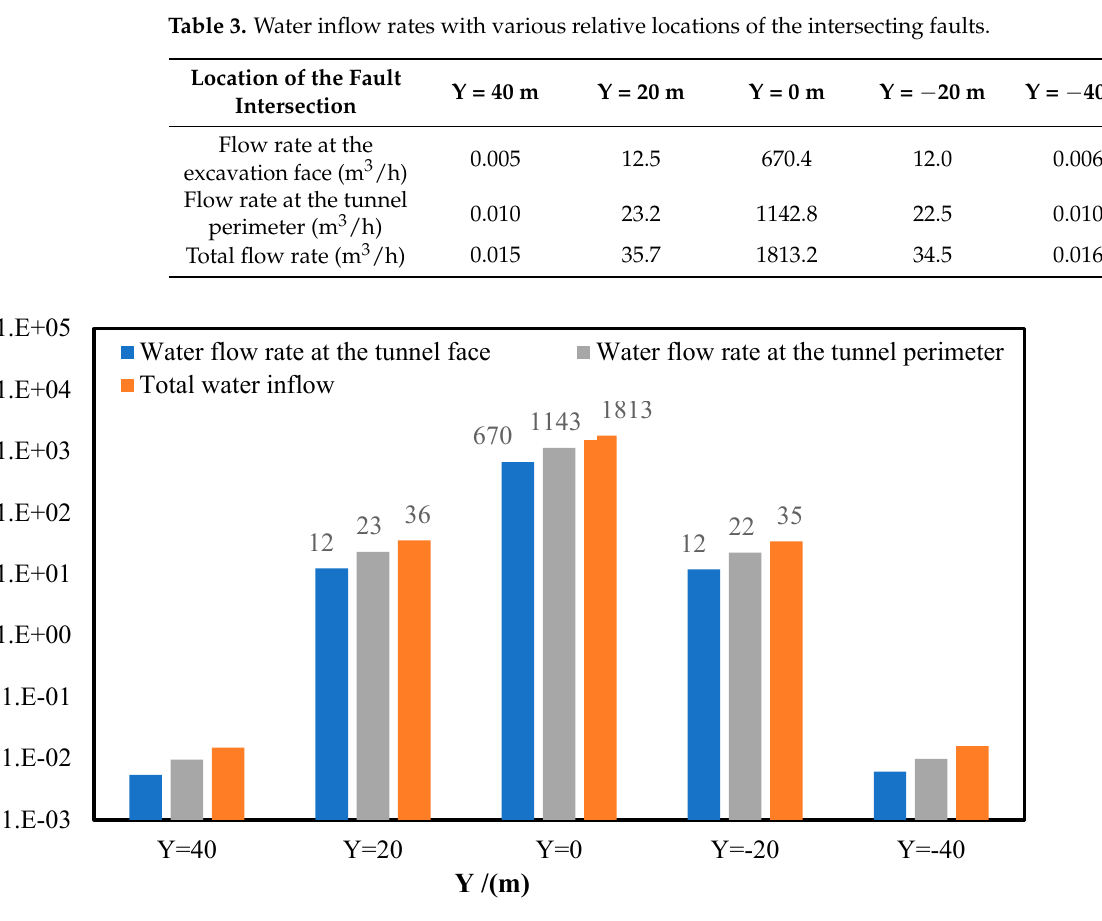
Figure 14. Bar chart of water inflow rates with different relative locations of the fault intersection (Y).